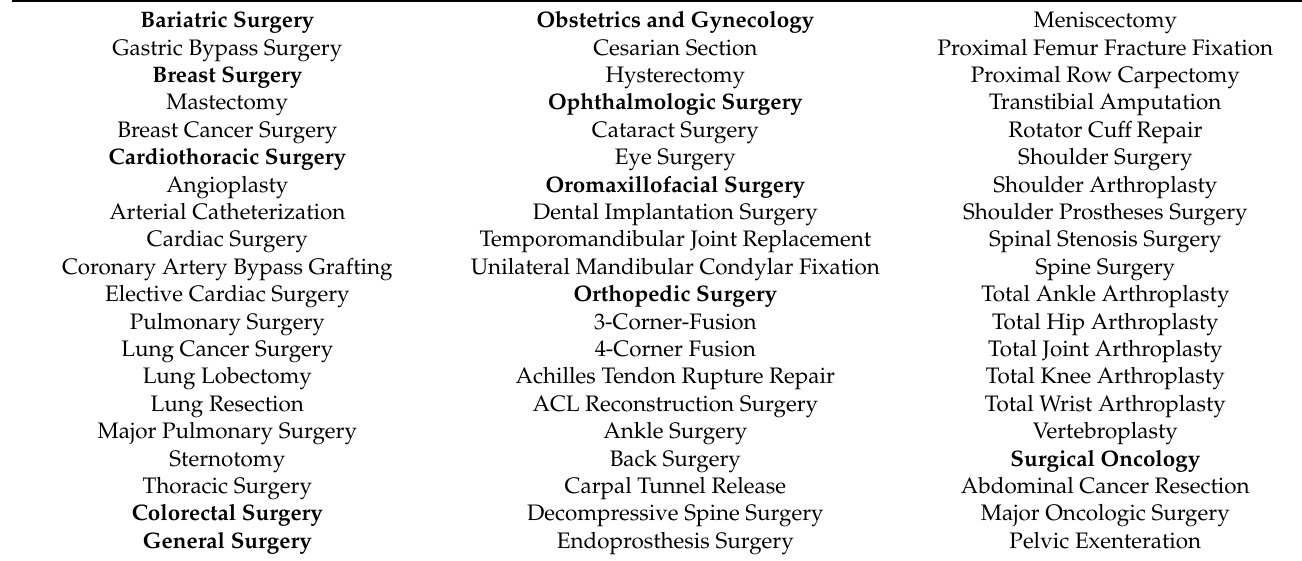
Table A3. List of Surgical Specialties and